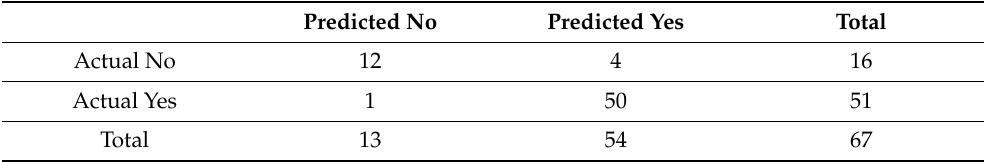
Table 1. Confusion matrix of ground-truth points collected to verify the accuracy of the geodatabase predictions.